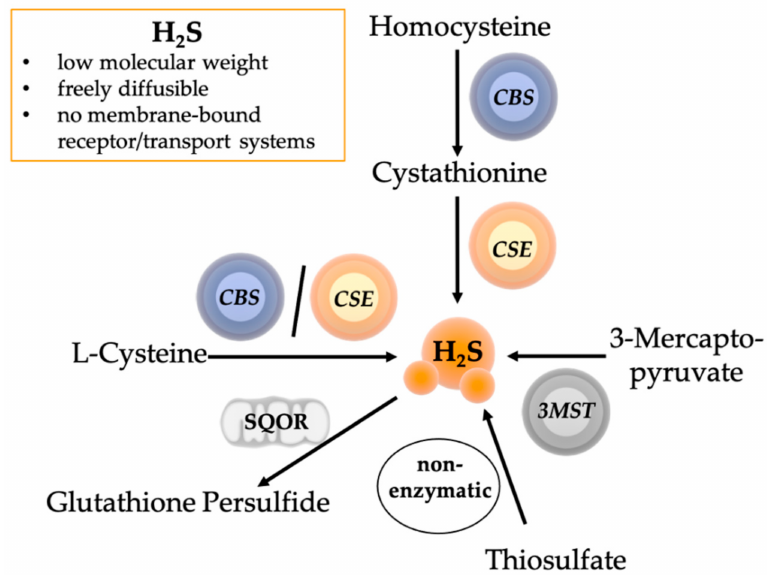
Figure 2. Hydrogen Sulfide (H 2 S) production and oxidation. H 2 S has a low molecular weight and is thus freely diffusible and acts independent of a membrane-bound receptor/transport system. H 2 S is produced enzymatically by three different enzymes: cystathionine γ -lyase (CSE), cystathionine- β -synthase (CBS), and 3-mercaptopyruvate sulphurtransferase (3MST). L-Cysteine is converted by CBS or CSE to H 2 S. Homocysteine is converted by CBS to cystathionine, which is then converted by CSE to H 2 S. Thiosulfate is an oxidation product of H 2 S, which is part of the stepwise enzymatic oxidation pathway within the mitochondria and can be utilized for non-enzymatic H 2 S production. In the mitochondria, H 2 S is oxidized by the sulfide:quinone oxidoreductase (SQOR) to